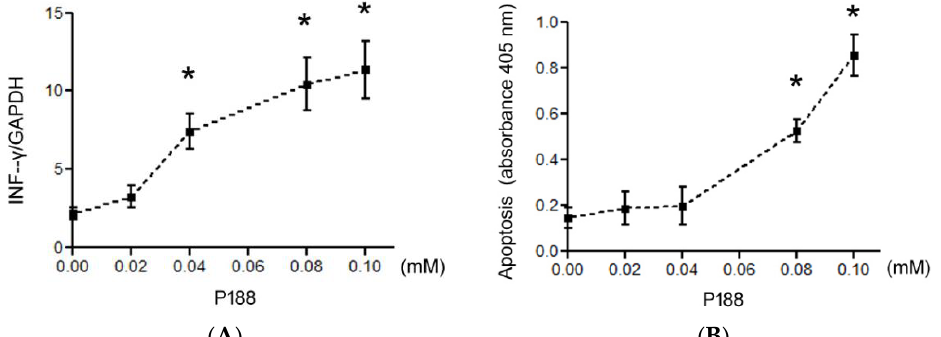
Figure 1. Dose-responsiveness of P188 affected expression in human PBMCs. RBD stimulated P188 (0, 0.02, 0.04, 0.08, or 0.1 mM)-cultured PBMCs for 24 h. ( A ) RT-qPCR showed P188 (0.04, 0.08, 0.1 mM) significantly increased IFN- γ. ( B ) Apoptosis assay showed P188 (0.08 and 0.1 mM) signifi- cantly triggered apoptosis. All results were presented as mean ± SD. * p < 0.05 vs. the control group (0